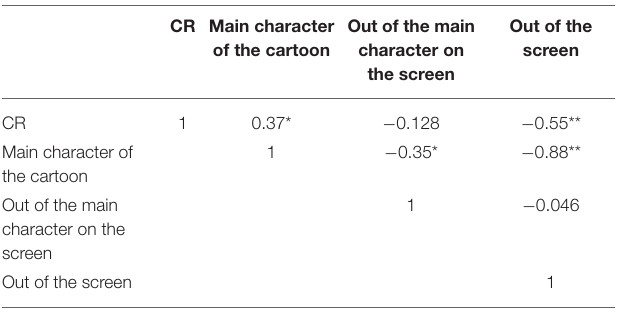
TABLE 5 | Pearson